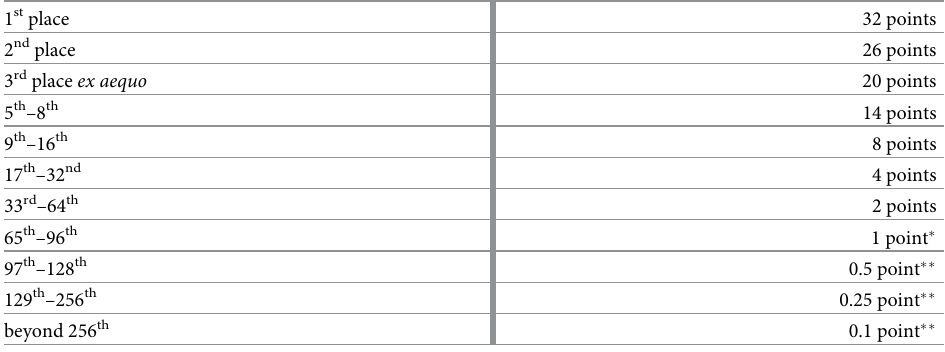
Table 2. Scale points in the official FIE